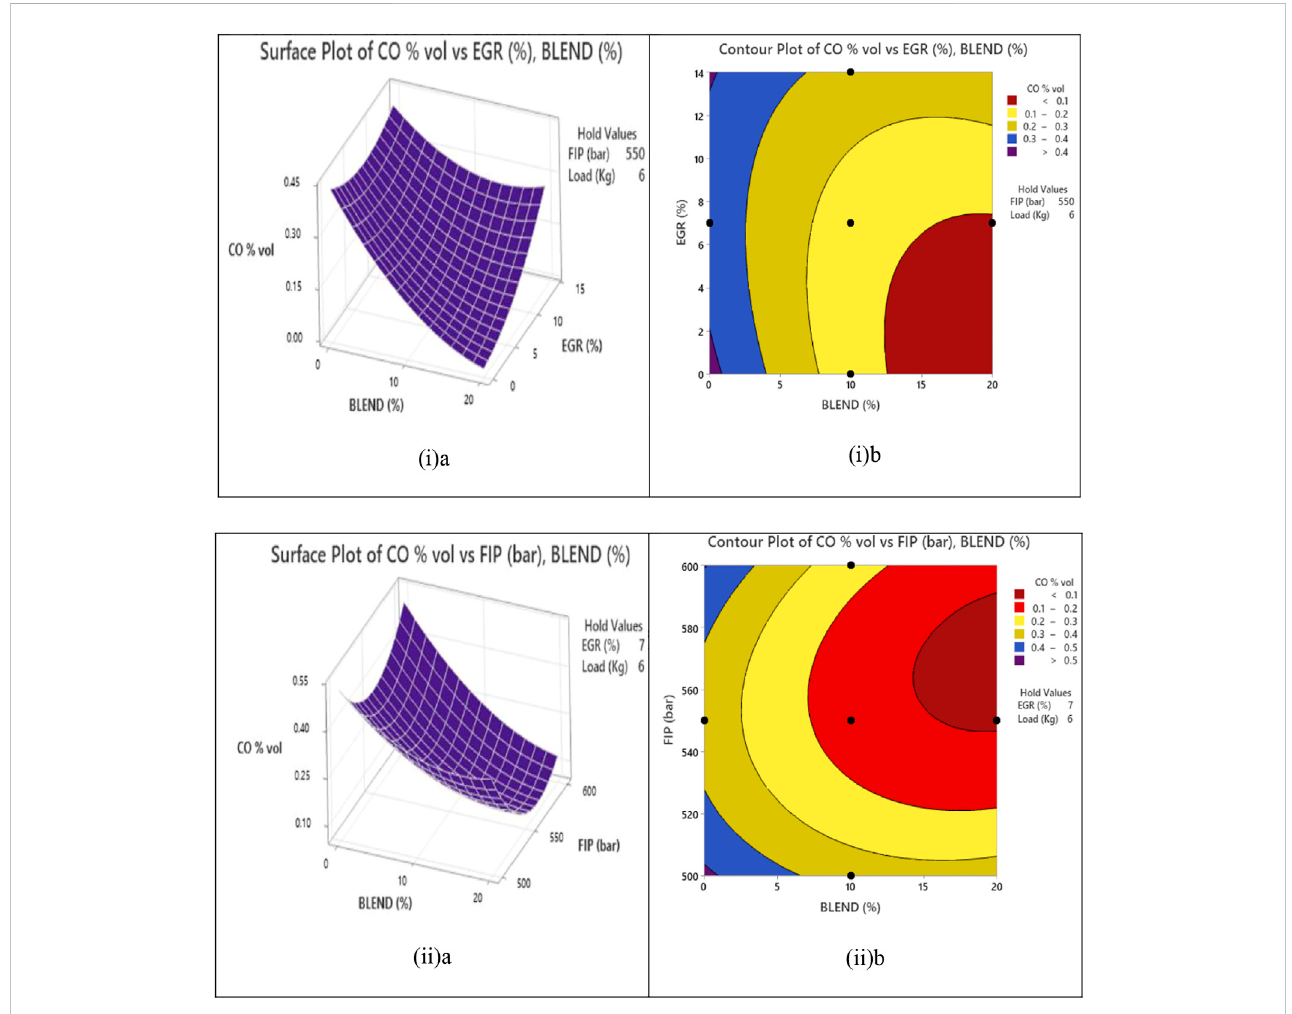
FIGURE 7 Effect of input factors on carbon dioxide (CO)